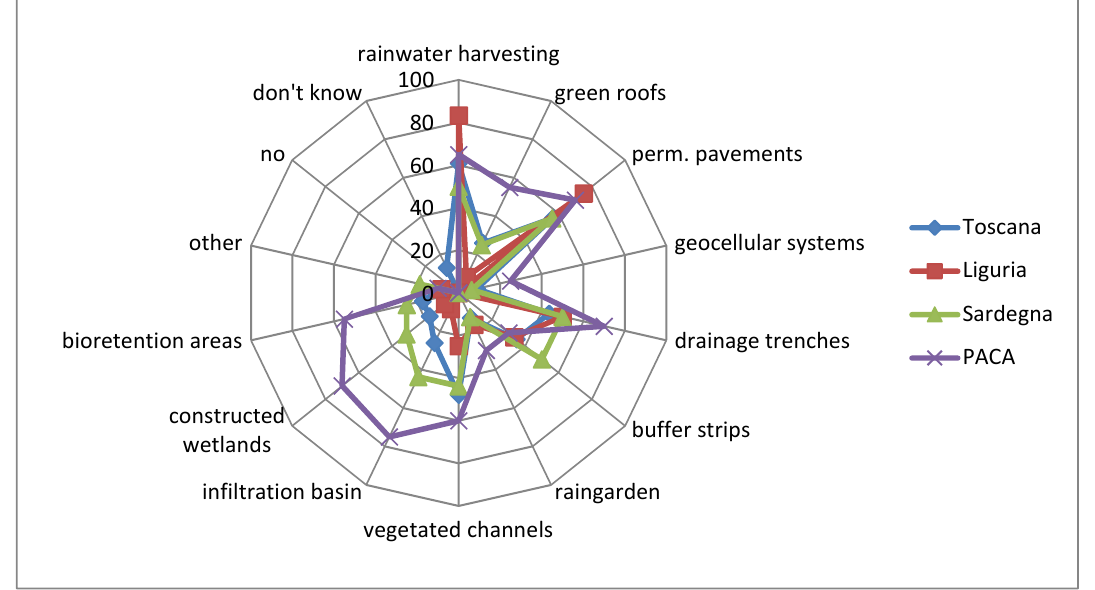
Figure 6. Stakeholder interest in di ff erent types of WrGIs / SuDSs as a percentage of those interviewed.